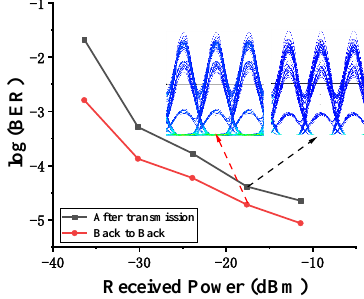
Fig. 5. BER performance of 650nm